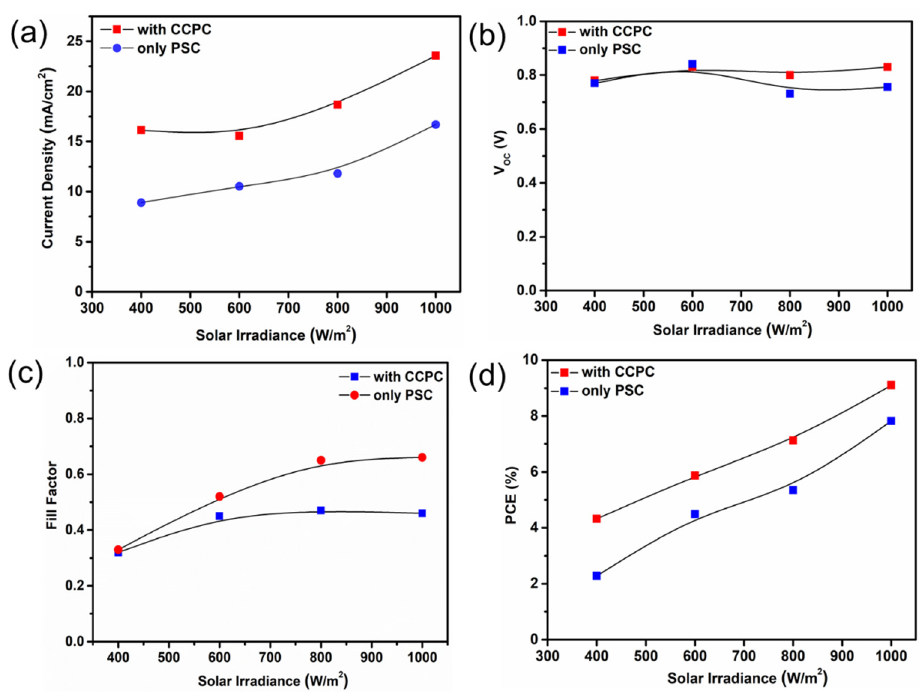
Figure 7. Plots of various photovoltaic parameters such as ( a ) current density, ( b ) open-circuit voltage, ( c ) fill factor, and ( d ) power conversion efficiency of the PCE compared with CCPC integrated PSC.